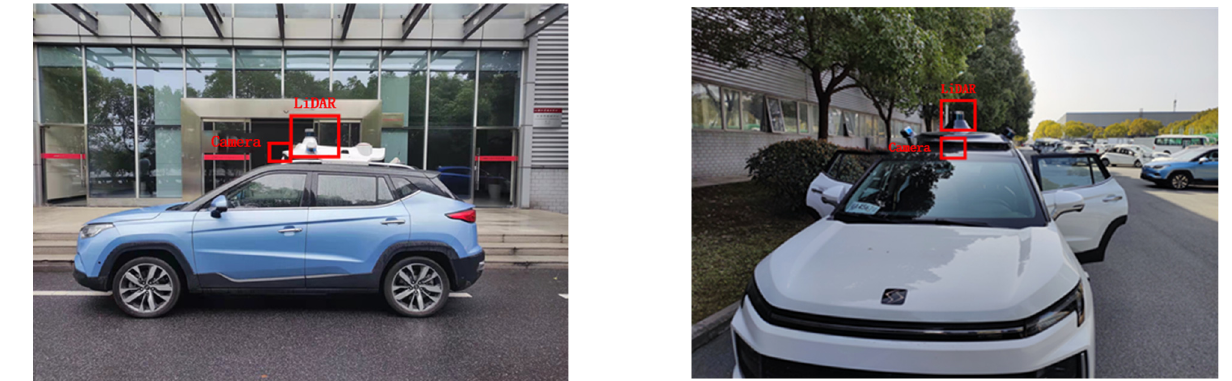
Figure 14. Environment perception system of the intelligent vehicle, the left figure shows the posi- tion of each sensor on the side, and the right figure shows the position from the front.